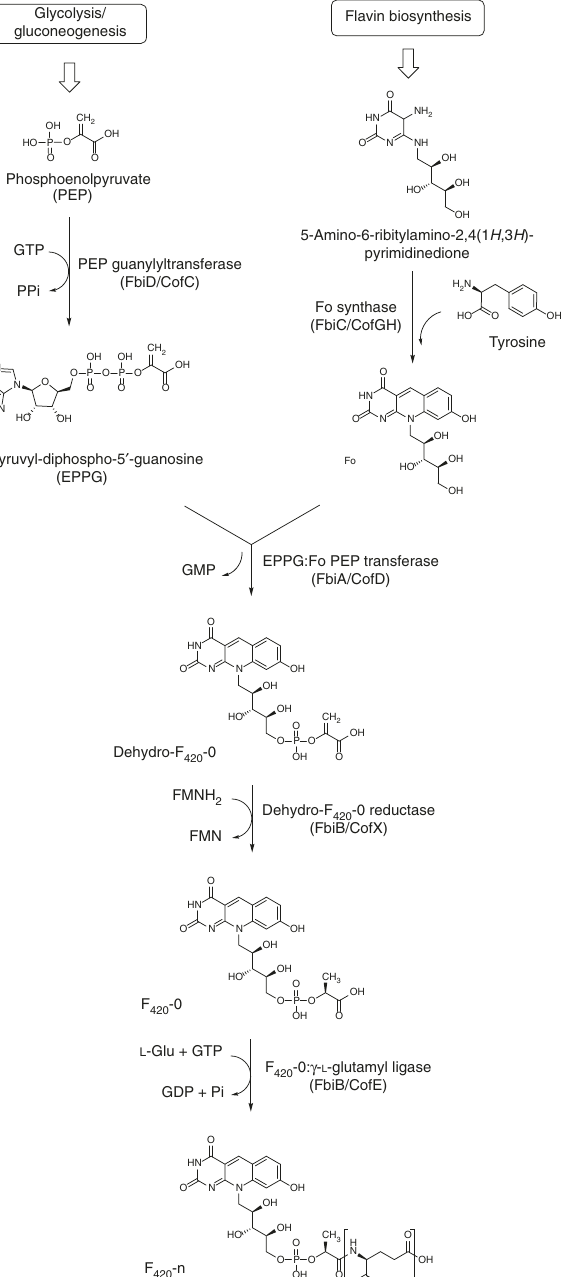
Fig. 6 The revised bacterial F 420 biosynthesis pathway. The revised pathway is a modi fi ed scheme showing that phosphoenolpyruvate (PEP) acts as the substrate for the FbiD/CofC enzymes to produce enolpyruvyl- diphospho-5 ʹ -guanosine (EPPG) or enolpyruvyl-diphospho-5 ʹ -adenosine (EPPA) (in the case of CofC). The immediate reaction product formed from Fo and EPPG/EPPA is dehydro-F 420 -0, which is reduced to F 420 -0 through the newly described reductase activity of the C-terminal domain of FbiB in mycobacteria. A separate enzyme in archaea and some bacteria is expected to catalyze this reduction step (CofX). FbiB/CofE subsequently adds a poly- γ -glutamate tail to form F “ Fbi ” refers to bacterial proteins, 420 .